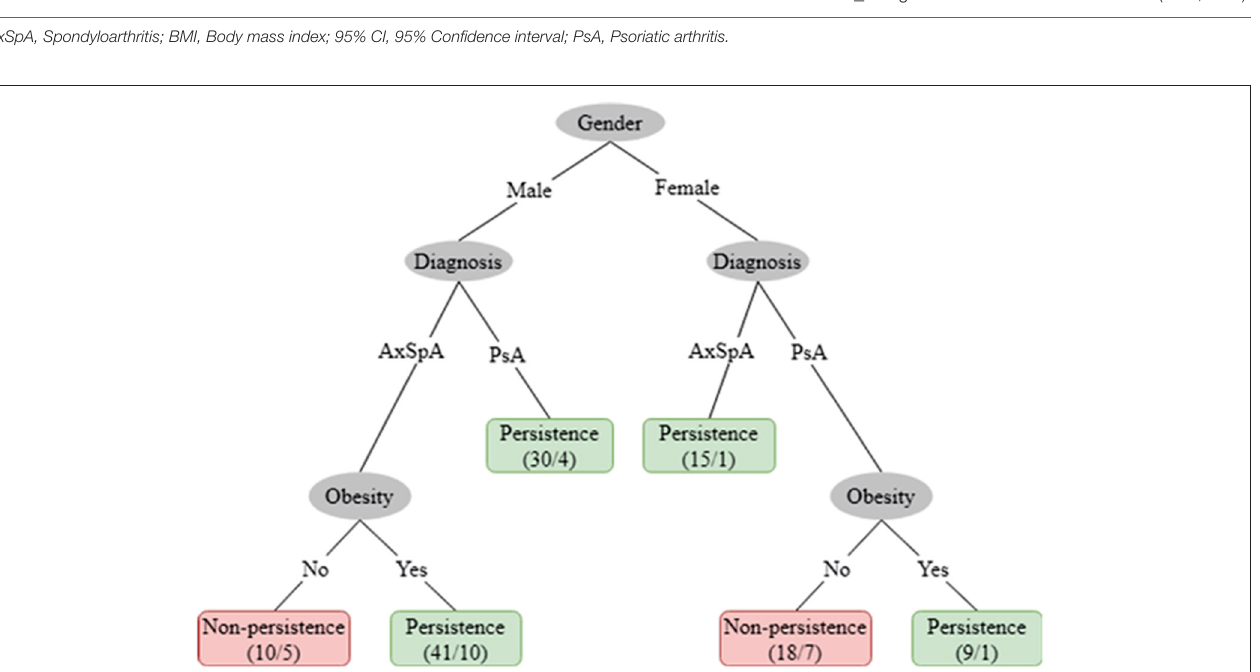
of secukinumab after a year of treatment under real-world secukinumab was recorded in AxSpA women and in PsA